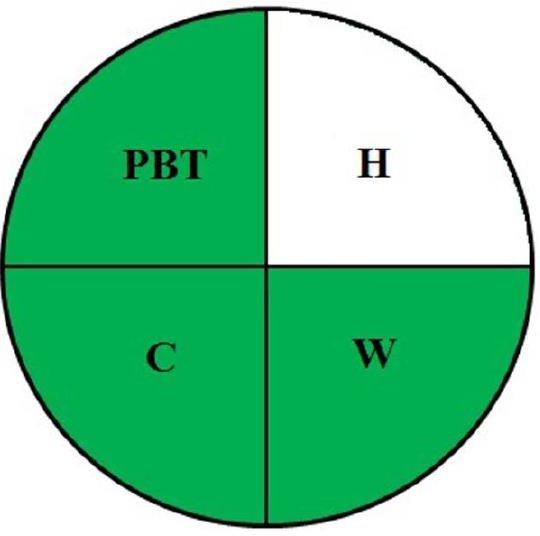
Figure 1. NEMI-oriented method greenness assessment pictogram. Table 1. Overall penalty points and greenness score of the current bioanalytical method.